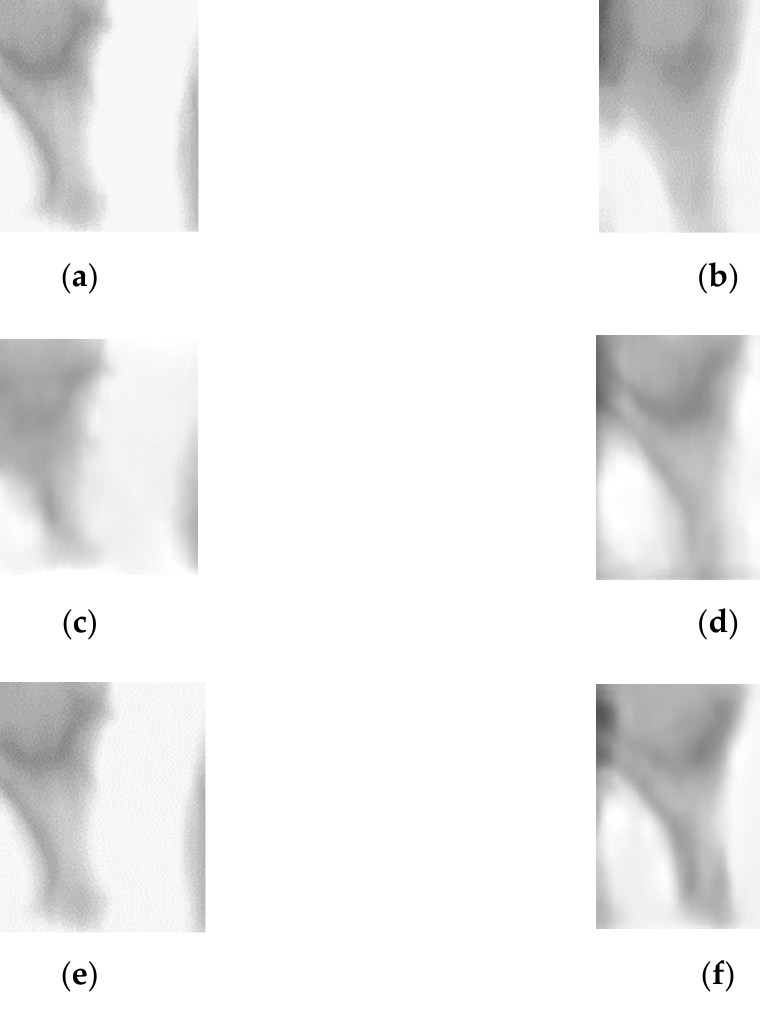
Figure 17. Examples of restored images using the state-of-the-art methods and the proposed modified DeblurGAN: ( a ) original images, ( b ) motion blurred images, and the restored images by ( c ) original DeblurGAN, ( d ) DeblurGANv2, ( e ) SRN-DeblurNet, and ( f ) proposed modified DeblurGAN. Figure 18a,c are the result of authentic and imposter matching prior to restoration, which provide incorrect matching results caused by modified vein patterns and texture information due to motion blur. Authentic matching was falsely rejected as imposter matching, whereas imposter matching was falsely accepted as authentic, thus decreased the recognition performance. Figure 18b,d are the results of correct matching by restoring the incorrect matching problem in (a) and (c) by the modified DeblurGAN. Authentic matching was classified as correct acceptance, and imposer matching was classified as correct